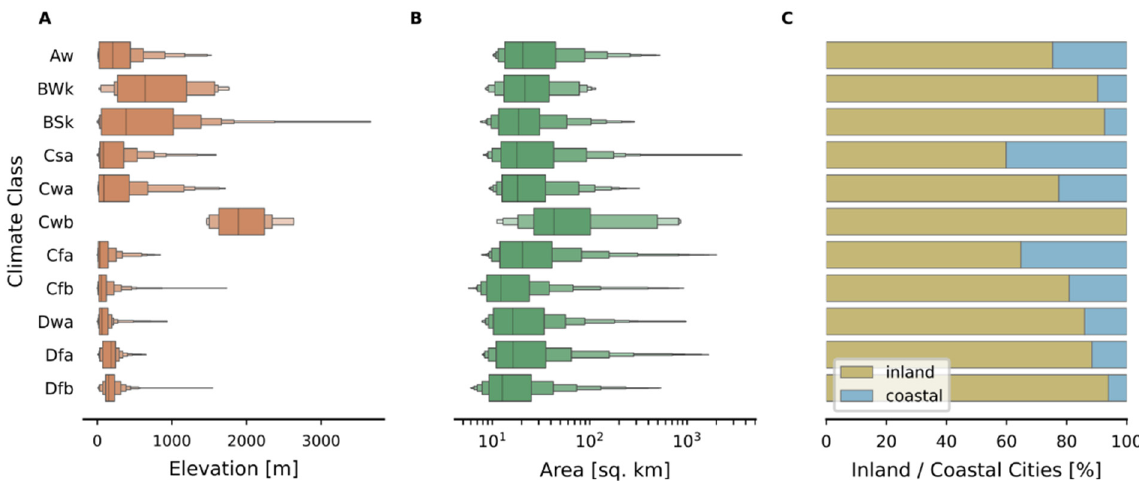
Figure A1. The distribution of city elevations ( A ) and sizes ( B ) and the percentage of inland and coastal cities ( C ) per Köppen–Geiger climate class.